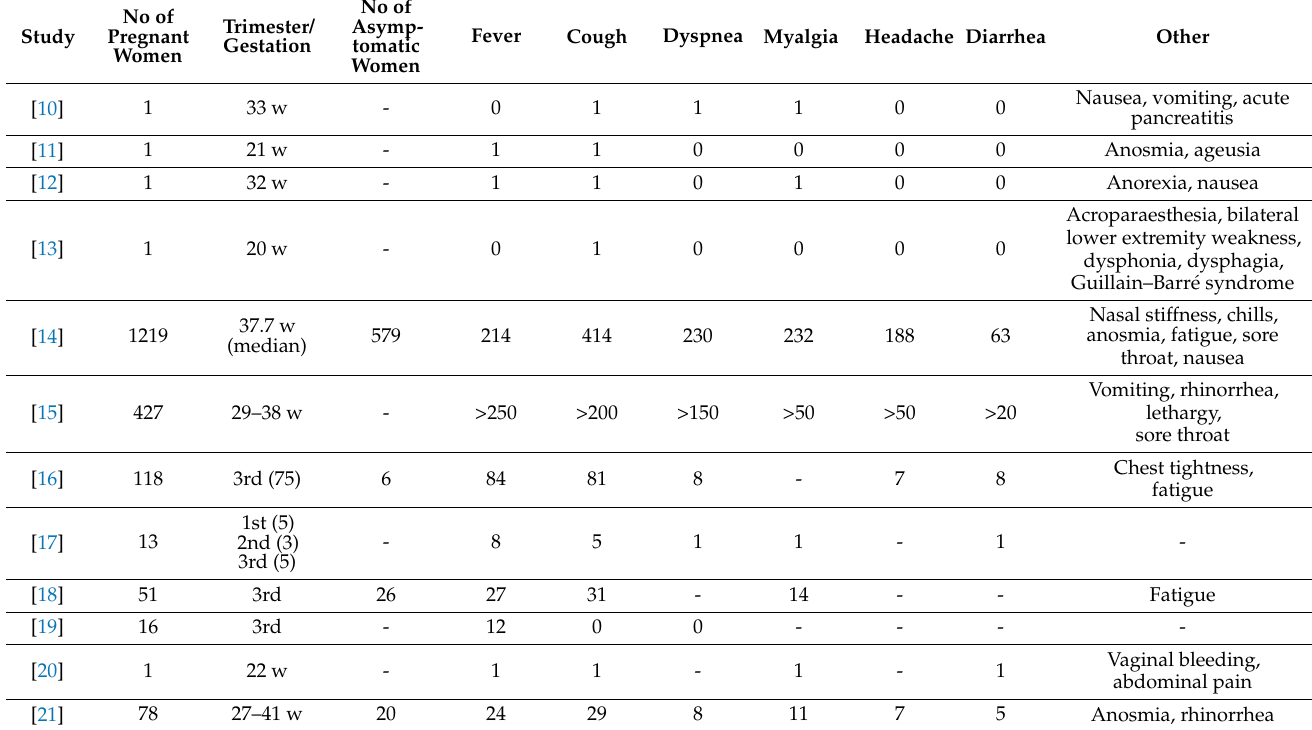
Table 1. An overview of the reported symptomatology in pregnant patients diagnosed with COVID-19, as described in the included